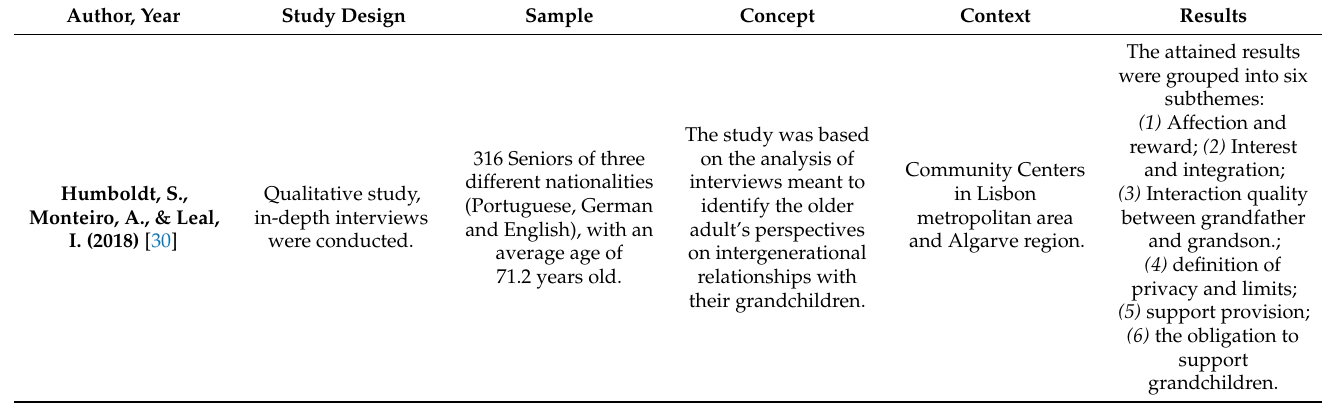
Table 3. Perception of professionals and older adults about intergenerational practices and